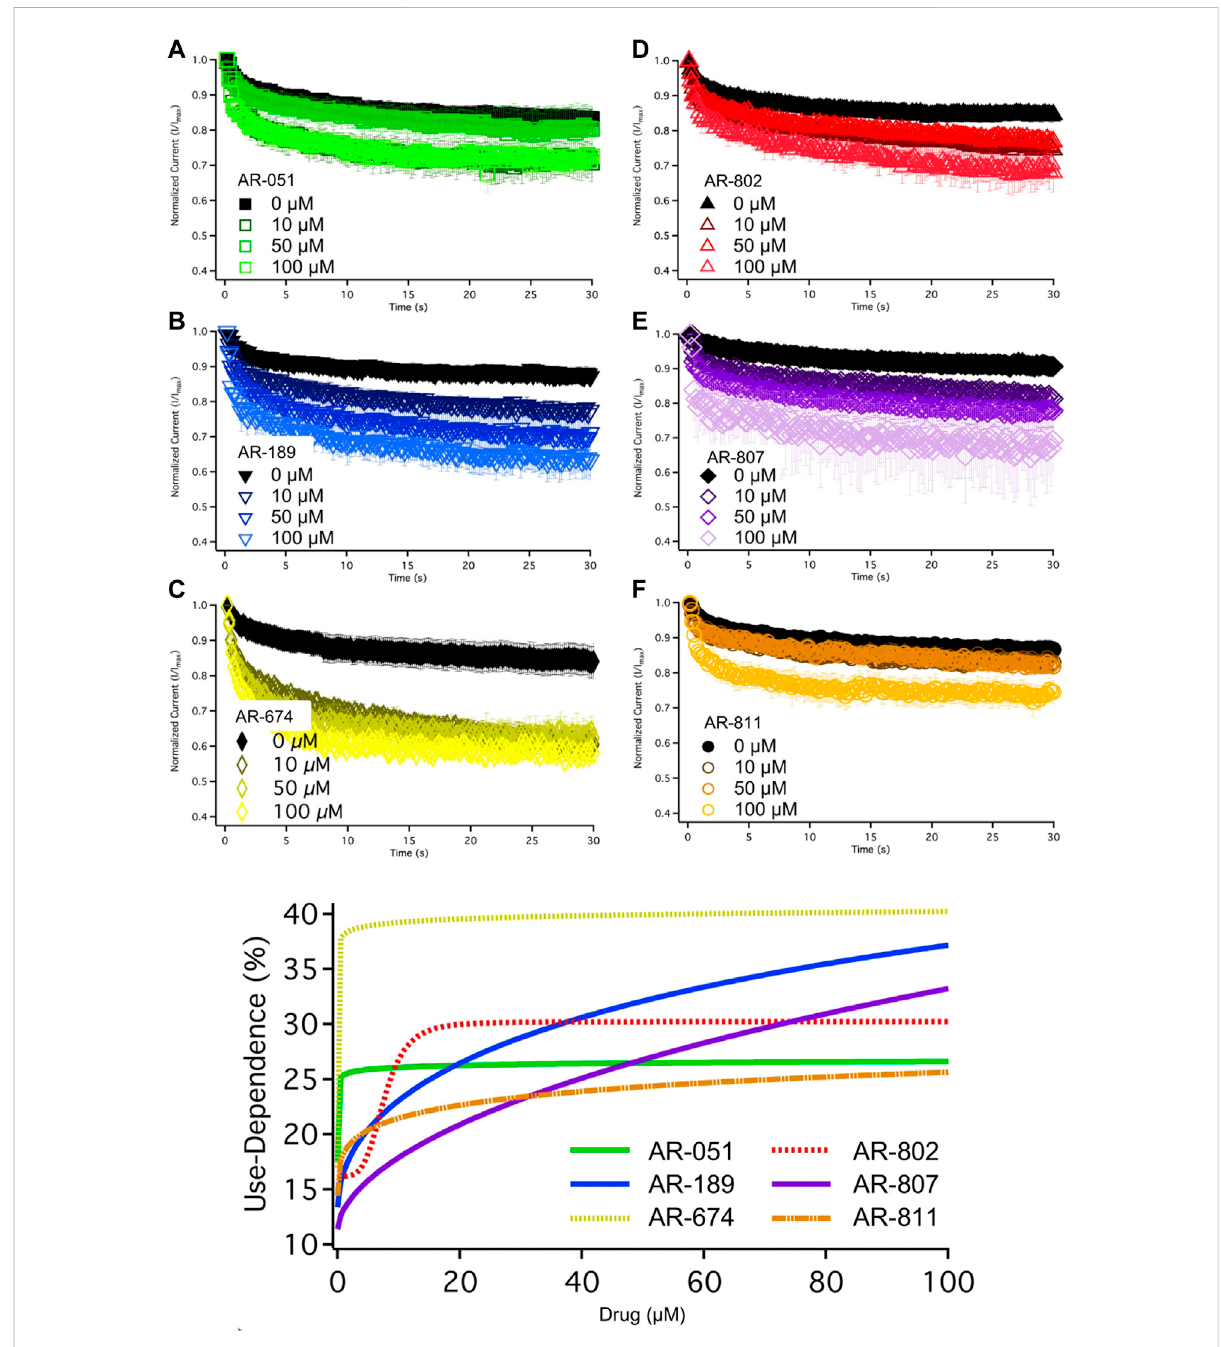
FIGURE 5 Use-Dependence. Nav1.5 use-dependence is shown for vehicle (black) and compound treatment (varied colors). A dose-response curve was fi tted to the compound concentrations for use-dependence (%), generating hill curves shown at the bottom of the fi gure. Statistical signi fi cance is reported in Table